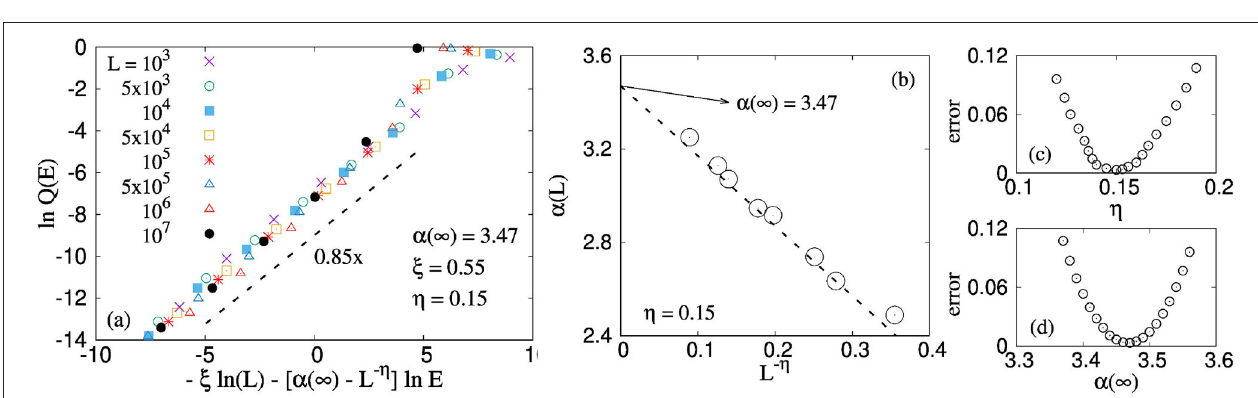
FIGURE 5 | (a) The finite size effect of Q ( E ) is shown for uniform threshold distribution, which follows a scaling: ln Q ( E ) = − ξ ln L − [ α ( ∞ ) − L − η ]ln E with η = 0.15, ξ = 0.55, and α ( ∞ ) = 3.47. (b) System size scaling of the exponent α as we approach the thermodynamic limit: α ( ∞ ) − α ( L ) ∼ L − η , with η = 0.15 and α ( ∞ ) = 3.47. (c,d) The least square fit error as a function of exponent η and α ( ∞ ), both with a minimum at a certain value. We consider the value of α ( ∞ ) and η which produces the minimum error. This same procedure has been followed next while exploring the same thing for different threshold distributions.